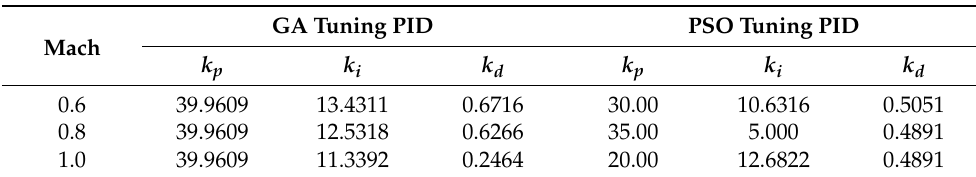
Table 2. PID parameters.